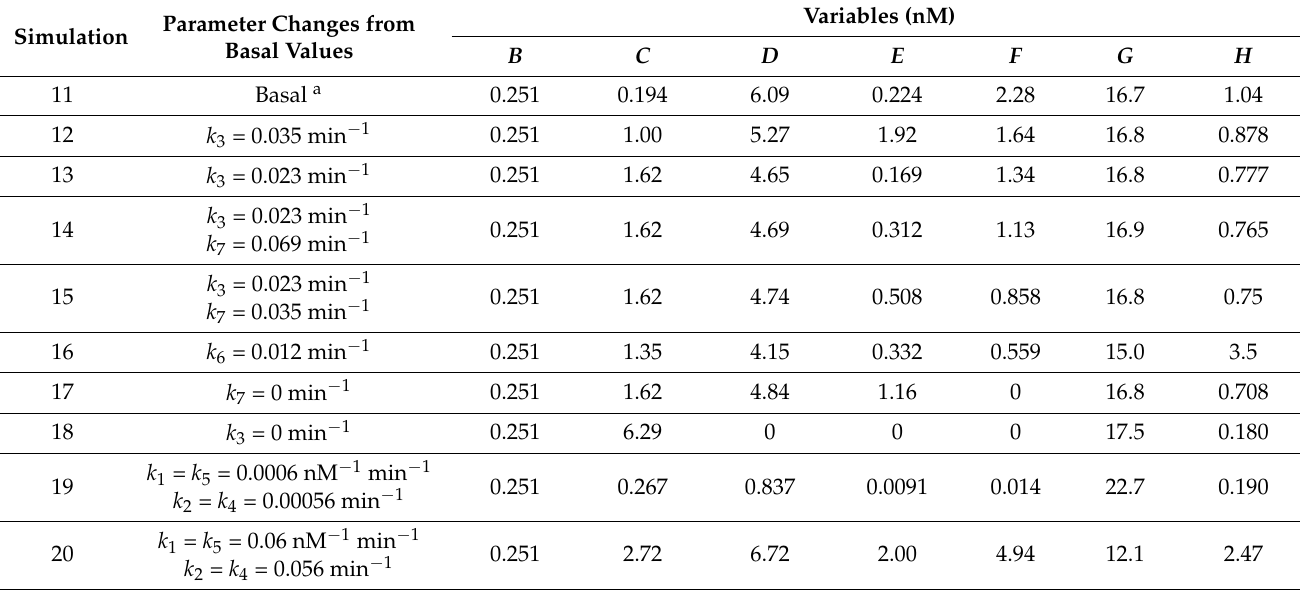
Table 8. IR model simulations of HIRMAb-IDUA fusion protein transcytosis through the BBB over 120 min after intravenous administration in the Rhesus